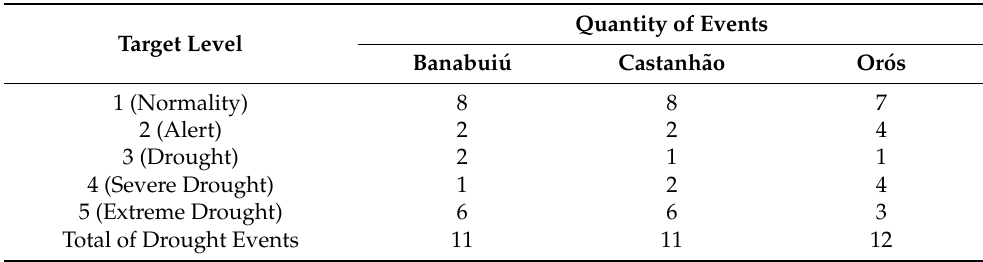
Table 8. Analysis of droughts in relation to the Target Levels for the Banabui ú , Castanh ã o, and Or ó s reservoirs.